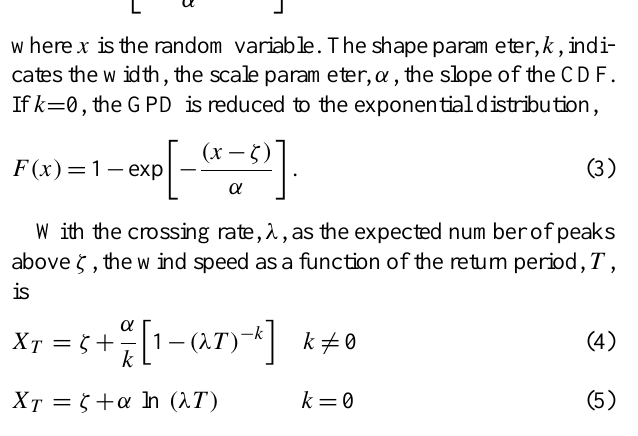
Fig. 1. Orography of Germany resolved at 1km × 1km with lo- cations of surface stations used for evaluation of the RCM results (white dots; black dots used in the comparison of Fig.